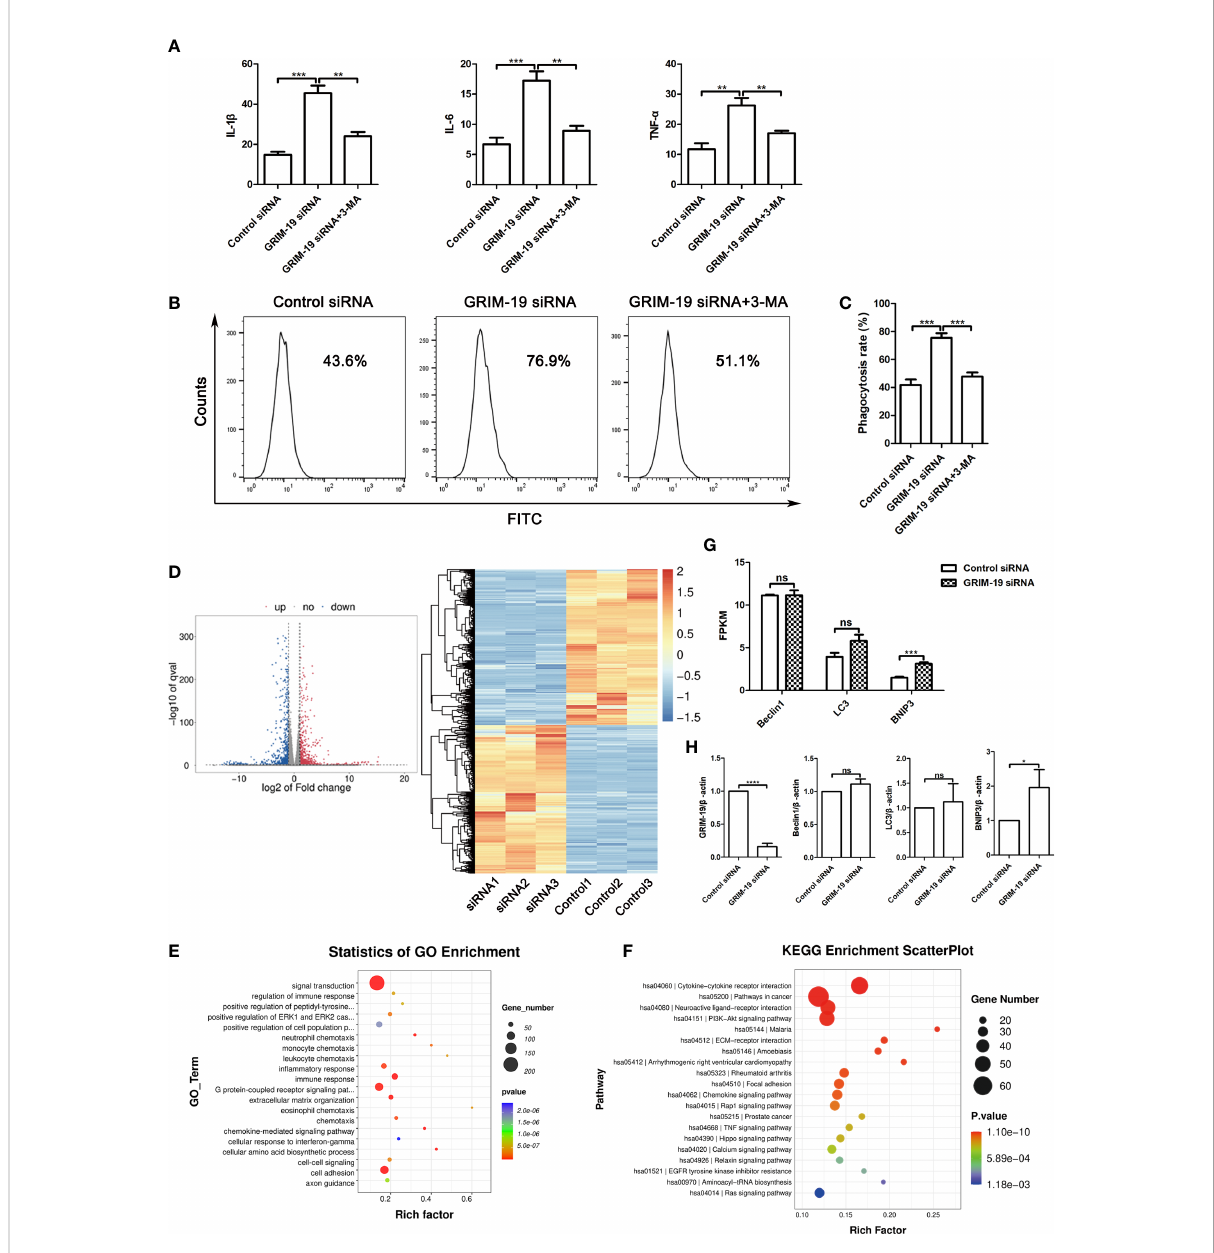
FIGURE 4 Downregulation of GRIM-19 promotes the release of proin fl ammatory cytokines and phagocytic activity, which can be reversed by autophagy blockade. (A) ELISA analysis of the proin fl ammatory cytokines IL1B, IL6 and TNFa in the supernatant of RAW264.7 cells in the control siRNA, GRIM-19 siRNA, and GRIM-19 siRNA + 3MA groups. Data are shown as the mean ± SD. Three independent experiments were carried out. (B) The intracellular FITC-dextran was measured by fl ow cytometric analysis in the control siRNA, GRIM-19 siRNA, and GRIM-19 siRNA + 3MA groups. The representative examples are shown. (C) The phagocytosis rate in the control siRNA, GRIM-19 siRNA, and GRIM-19 siRNA + 3MA groups was identi fi ed. Three independent experiments were carried out. Data are shown as the mean ± SD. (D) Volcano plot and cluster analysis of differentially expressed genes from RNA-seq data in Grim-19 and control siRNA treated THP-1-derived macrophages. (E) The enriched Gene Ontology terms of biological process categories of differentially expressed genes from RNA-seq data in Grim-19 and control siRNA treated THP-1-derived macrophages. (F) KEGG analysis of differentially expressed genes from RNA-seq data in Grim-19 and control siRNA treated THP-1-derived macrophages. (G) The expression levels of Beclin1, LC3, and BNIP3 at the transcriptome level were quanti fi ed as FPKMs in RNA-seq. The differential gene expression was identi fi ed using DESeq2 software. The genes with the parameter of false discovery rate (FDR) below 0.05 and absolute fold change ≥ 2 were considered differentially expressed genes (| log 2 FC| ≥ 1 & q<0.05). (H) The mRNA levels of the Beclin1, LC3, and BNIP3 were detected by quantitative real-time PCR. **** p < 0.0001, *** p < 0.001, ** p < 0.01, * p < 0.05, ns, not signi fi